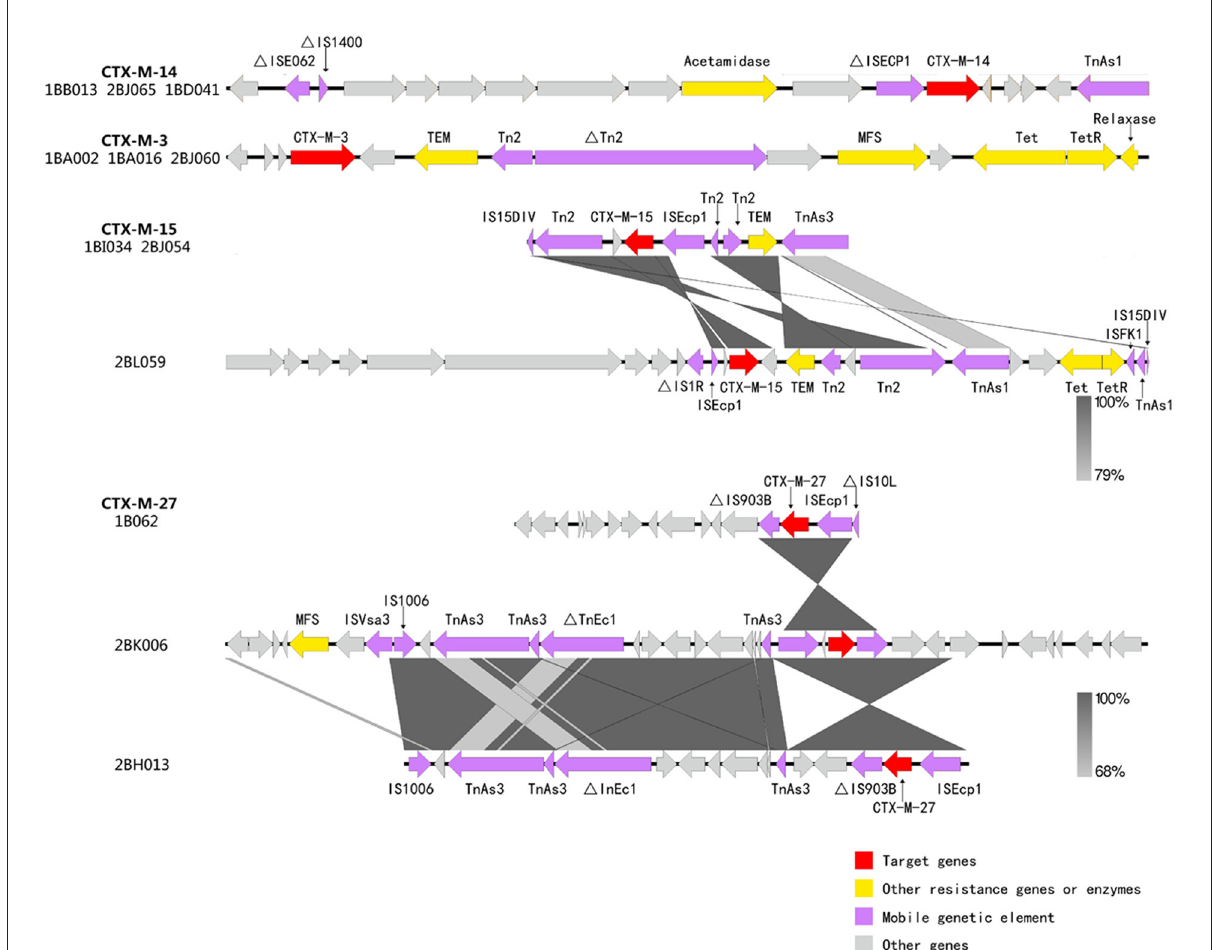
FIGURE5 Analysis of the genetic environment surrounding the bla CTX − M gene. Arrows represent the direction of transcription. Red filled blocks represent CTX-M, yellow filled blocks represent resistance-related proteins, purple filled blocks represent mobile genetic elements, and gray filled blocks represent other